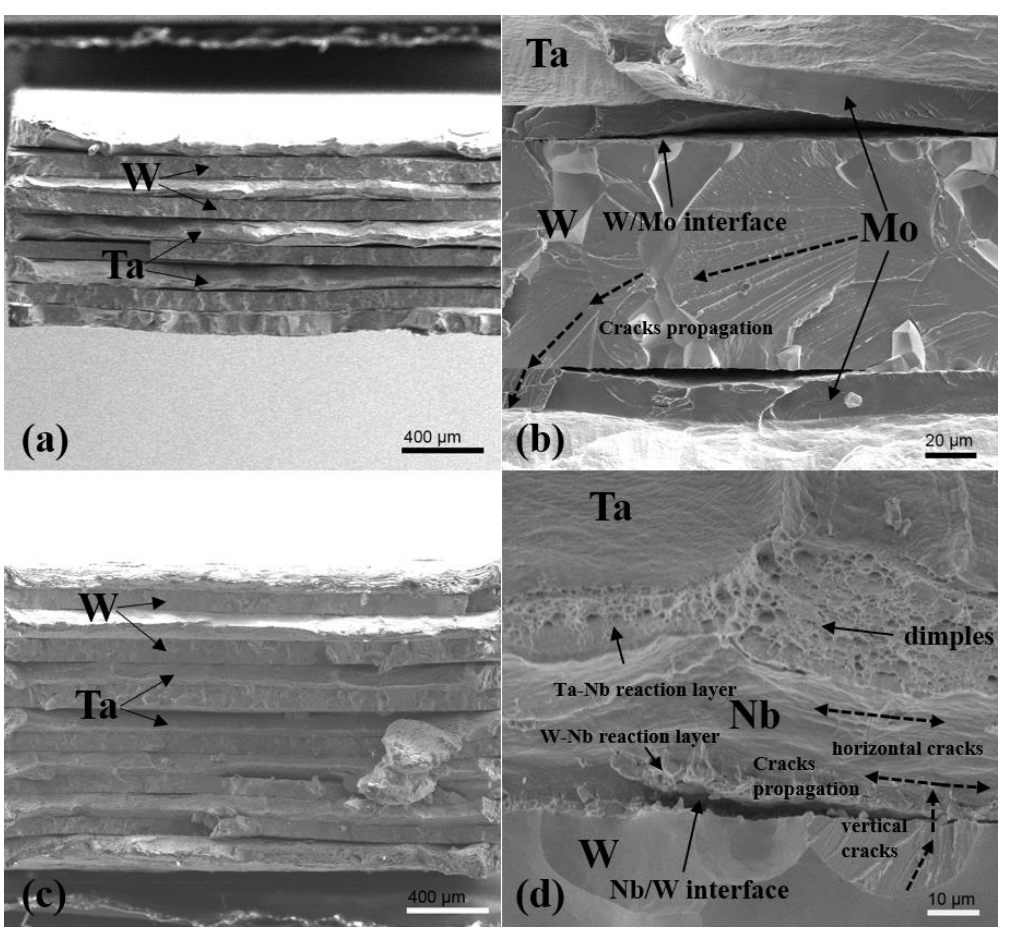
Figure 5. Tensile fracture morphology of ( a , b ) W / Mo / Ta and ( c , d ) W / Nb / Ta laminates.